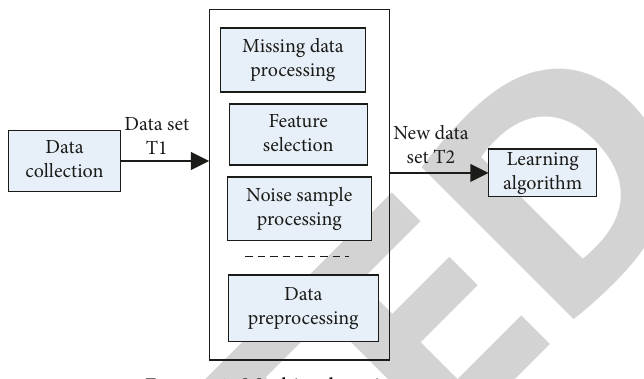
Figure 1: Machine learning